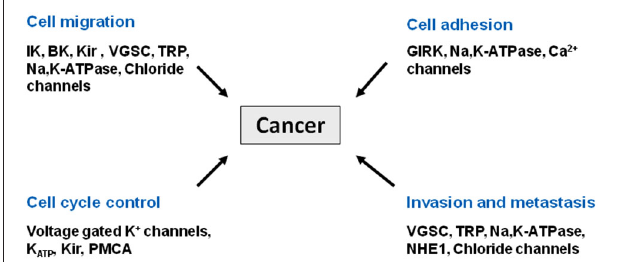
FIGURE 1 | Cancer as a channelopathy . Mutations, loss of expression/function and aberrant expression/function of ion channels and transporters have been linked to various cancers. Aberrant cell migration, cell adhesion, and cell cycle control all contribute to the invasive phenotype associated with